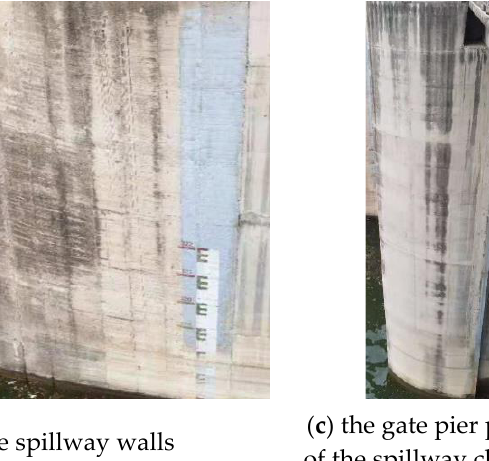
Figure 4. Erosion wear of spillway.